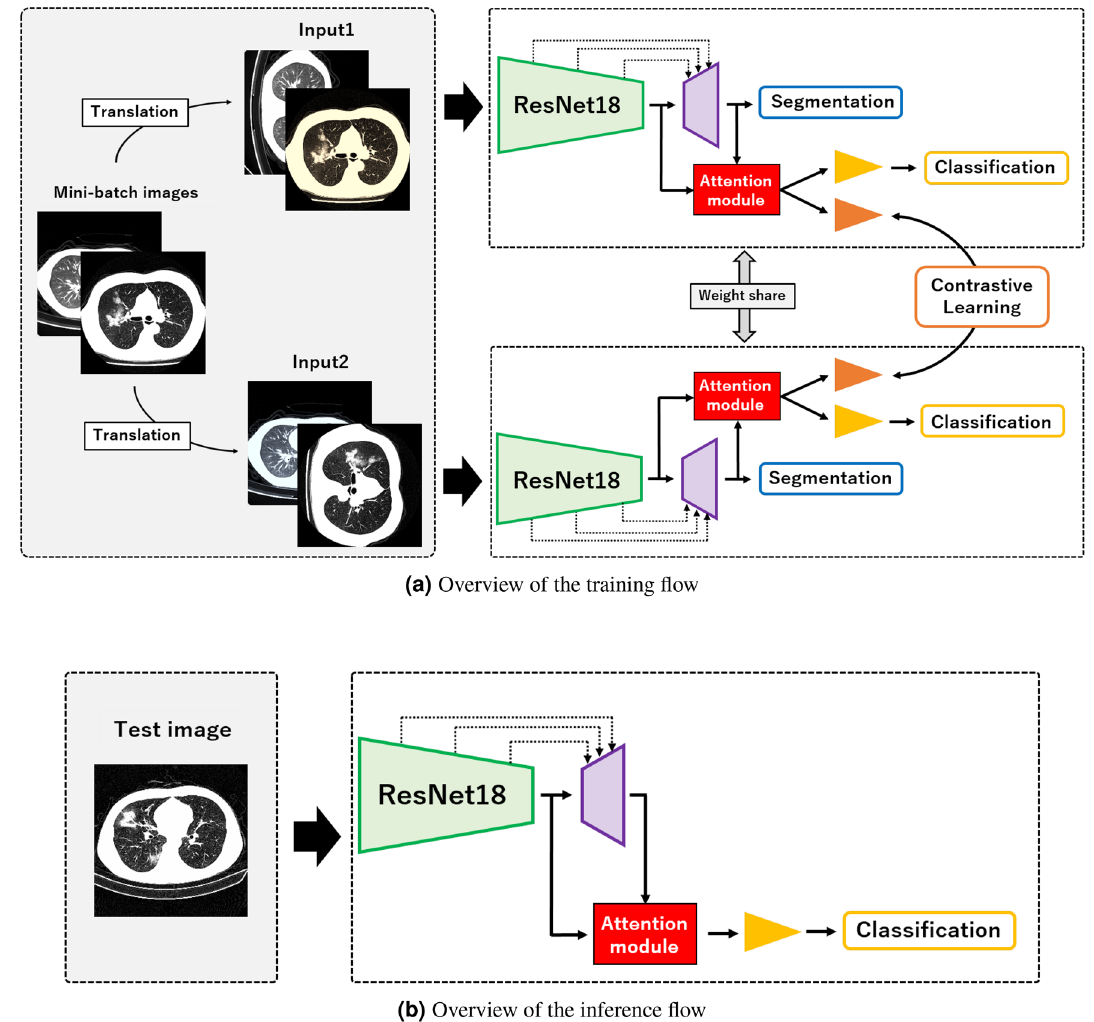
Figure 1. Overview of proposed method for the training and inference